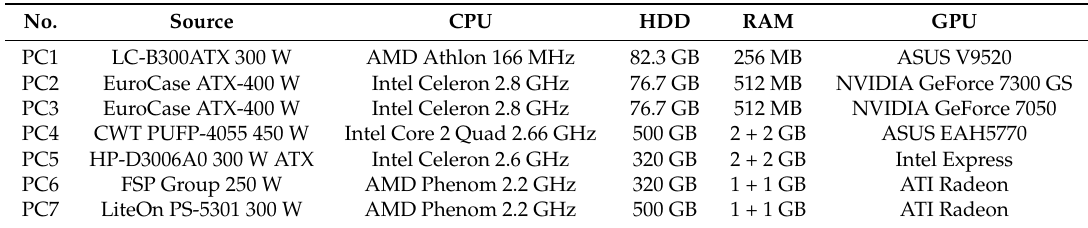
Table 2. List and description of tested